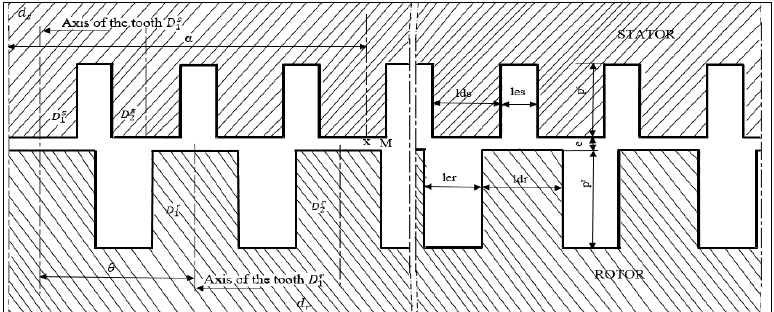
Figure 1. Geometrical parameters of the machine used in the analytical model.